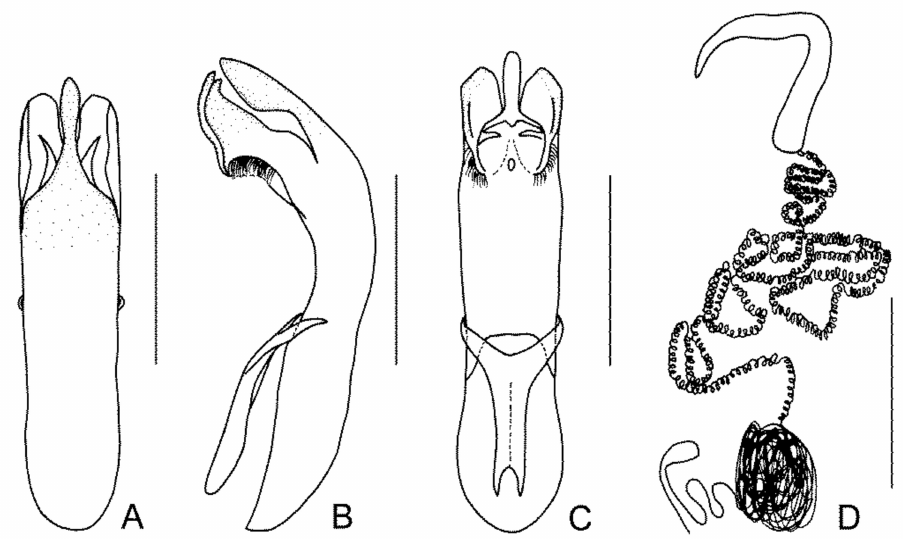
Figure 25. Cryptocephalus ( Burlinius ) nigrofasciatus Jacoby, 1885: ( A ) dorsal view of aedeagus; ( B ) lat- eral view of aedeagus; ( C ) ventral view of aedeagus; ( D ) spermatheca (Scale bars: 0.5